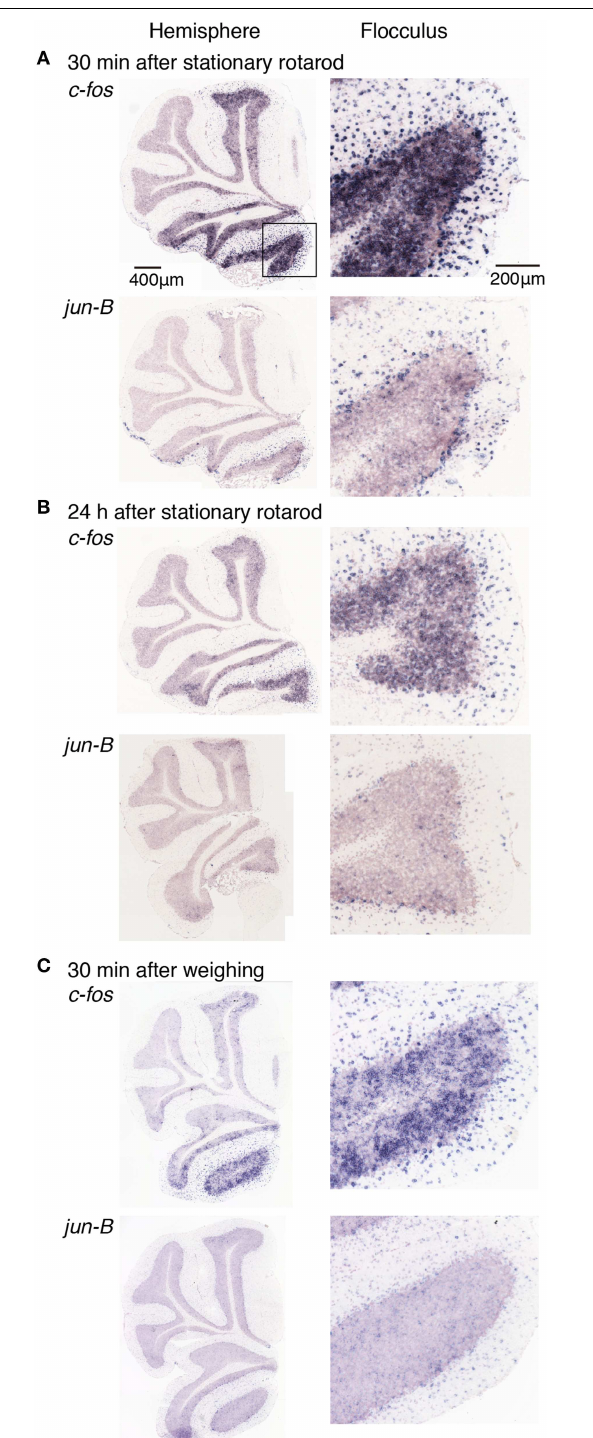
FIGURE 7 | Expression levels of c-fos and jun-B mRNAs in the cerebellum of mice after stationary rota-rod task or single weighing. Mice that did not experience any motor tasks (untrained) were sacrificed (A) 30min, (B) 24h after the stationary rod task (see Materials and Methods), or (C) 30min after single weighing. Right panels show magnified images of floccular